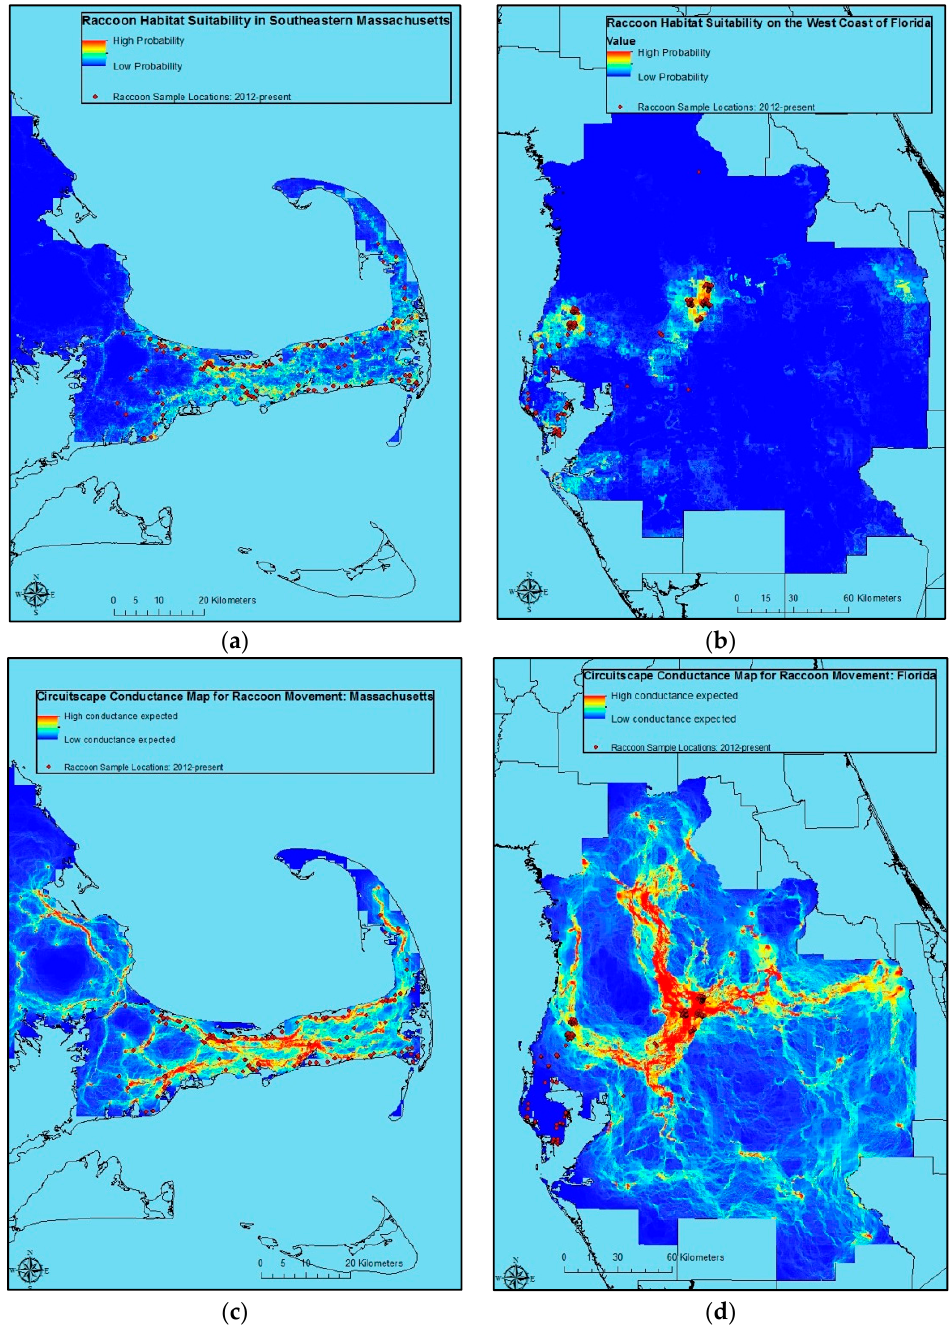
Figure 2. Maxent raccoon location probability map based on samples from Massachusetts( a ; n = 171) and Florida ( b ; n = 431) collected during 5 January 2012–26 June 2014) plus annual mean precipitation, annual mean temperature, elevation, land cover/land use, human population density, housing density, Euclidean distance to roads, USDA Soil Taxonomic Order, Euclidean distance to streams/rivers, and Euclidean distance to water bodies; and related Circuitscape conductance maps for raccoon rabies risk in Massachusetts ( c ) and Florida ( d ).